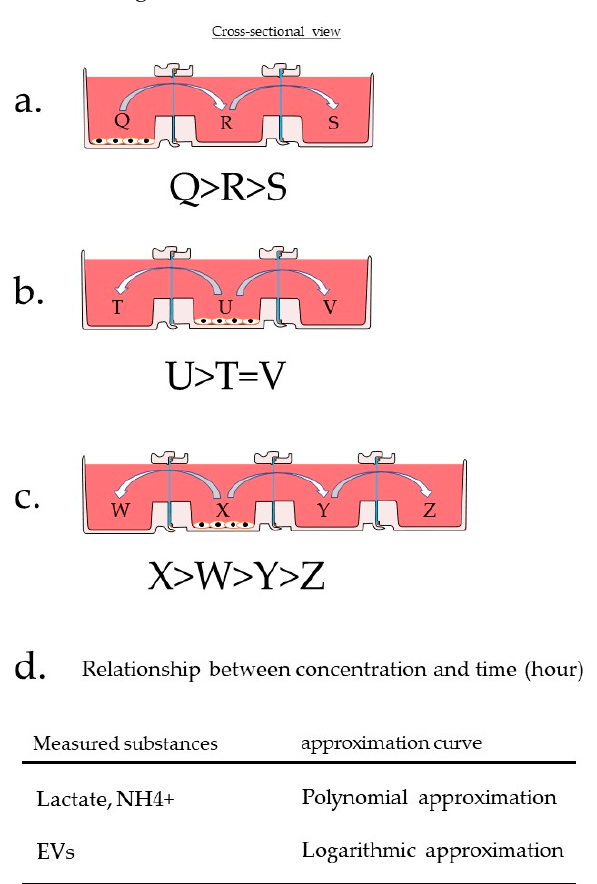
Figure 10. Material concentration gradient caused by multiple linkages ( a ) When cells are placed in the leftmost container (Q) in a three-container system, the concentration of the substances from the cells increases in Q. ( b ) When cells are placed in the middle container (U) of a 3-connected container, the concentrations of substances from the cells in the containers at both ends (T and V) are the same. ( c ) If the cells are placed in the second vessel from the left (X) in a four-connected container, W = Y will not be true because Y will be diluted by the influence of Z, resulting in W > Y > Z. ( d ) In the relationship between concentration and time, the concentration in each container can be represented by an approximate curve, with a correlation coefficient of almost 1. The approximate formulas and coefficients in each case are shown in the graphs. The data are described in Supplementary Table S3.